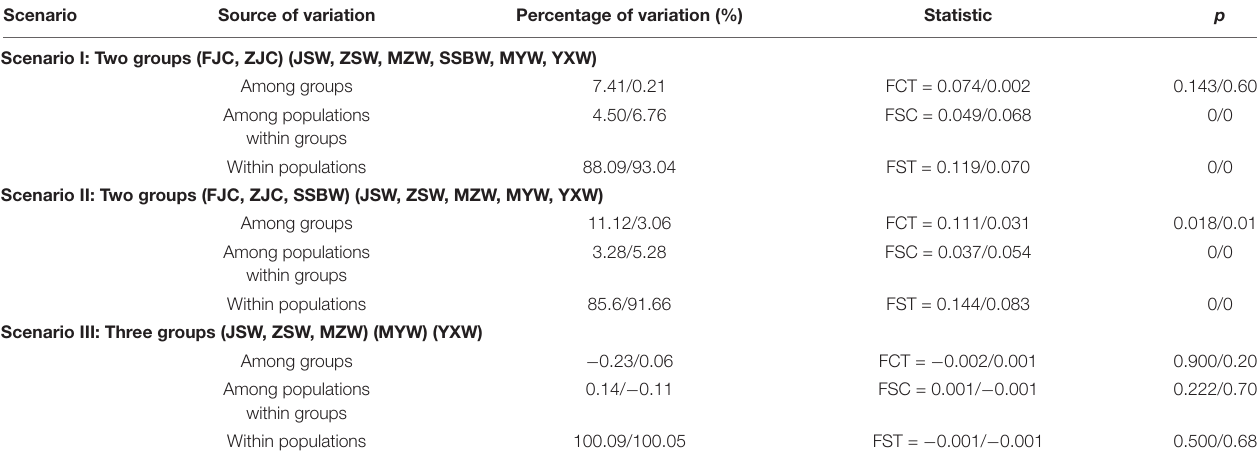
TABLE 3 | AMOVA analysis based on mtDNA (former) and nuDNA (latter) fragments.